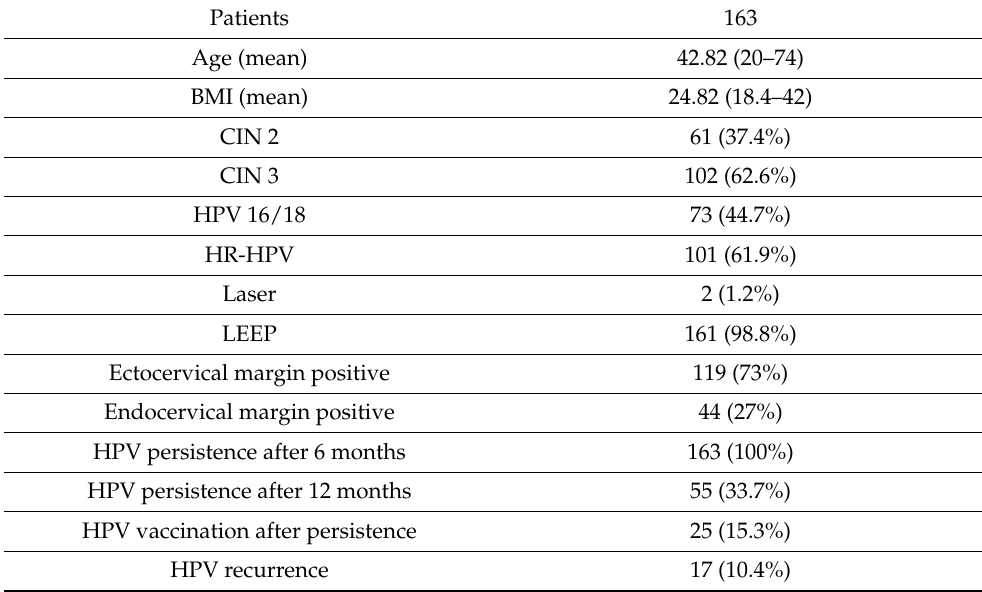
Table 1. Characteristics of the study